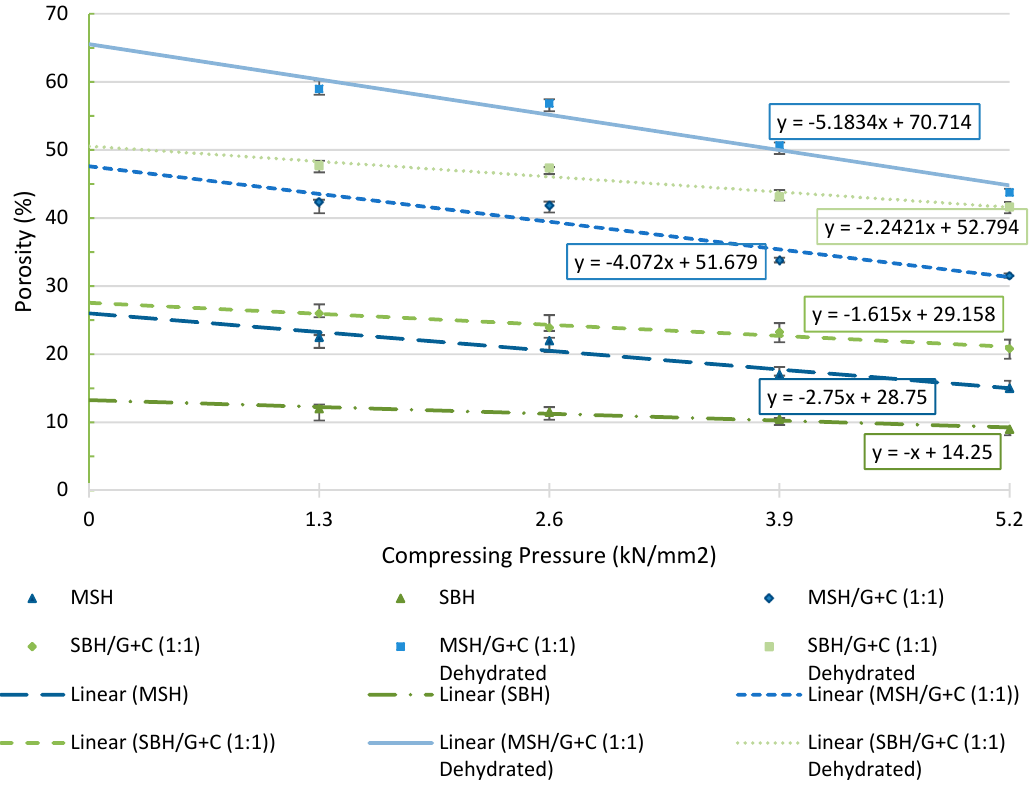
Figure 29. Porosity test results for pellets manufactured at the different compression pressures.